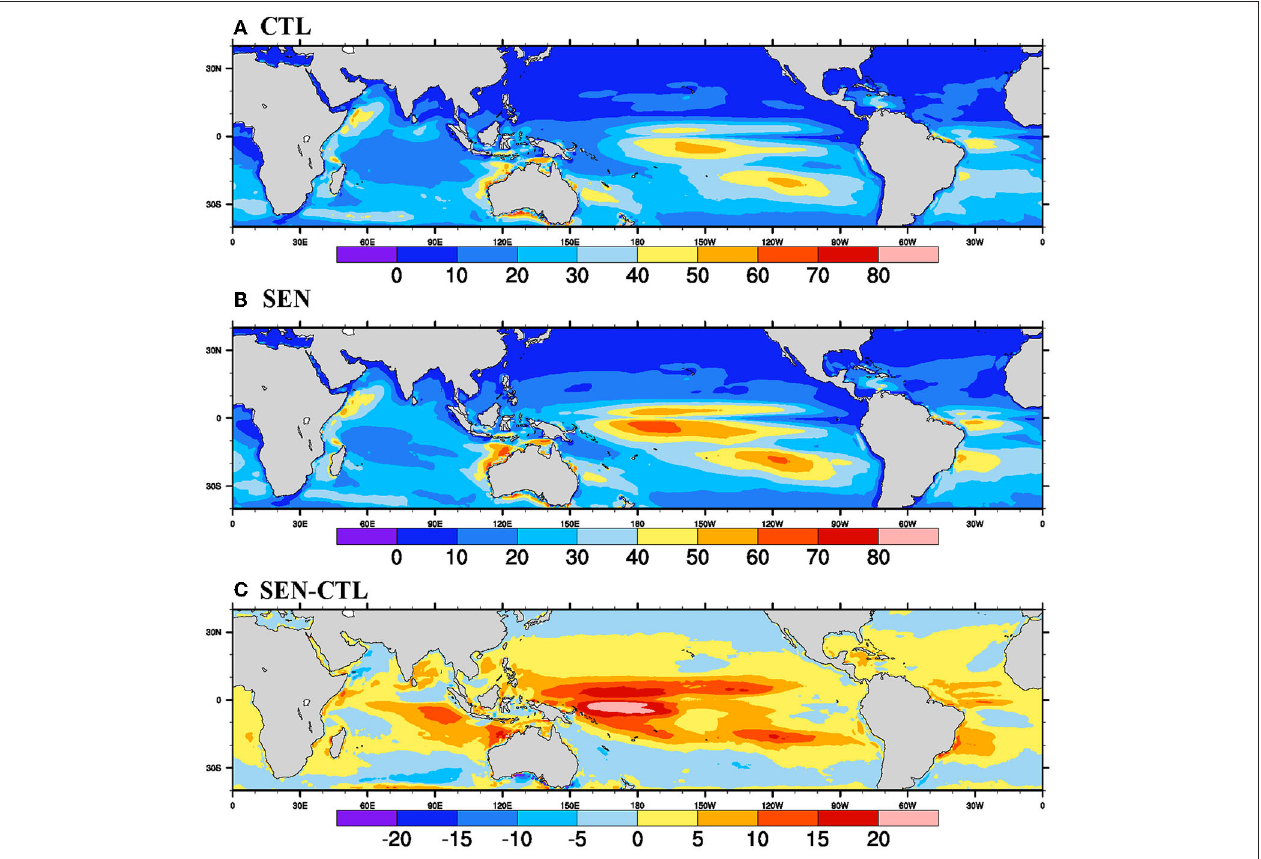
FIGURE 2 | Seasonal (JJAS) Mean diurnal range of MLD ( dMLD = maximum-minimum during 24-h cycle in m) from (A) CTL, (B) SEN run, and (C) SEN minus CTL for the period